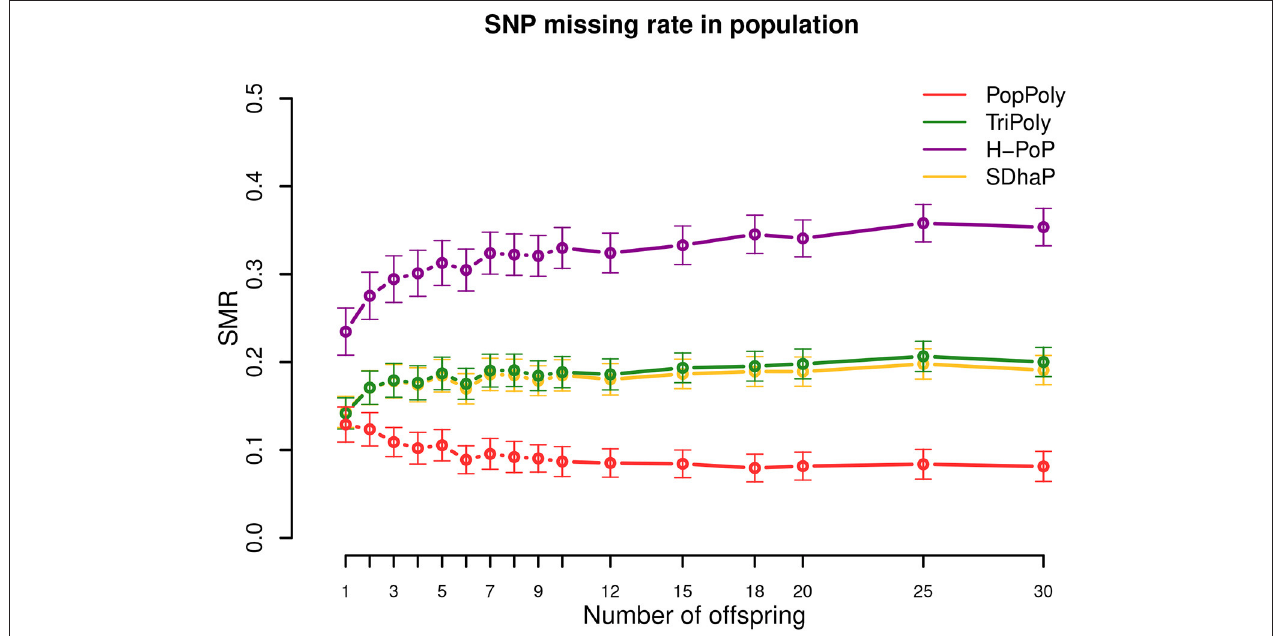
FIGURE 3 | SNP missing rate (SMR) in the population against the number of offspring reported by PopPoly (red), TriPoly (green), H-PoP (purple), and SDhaP (yellow) for simulated tetraploid potato